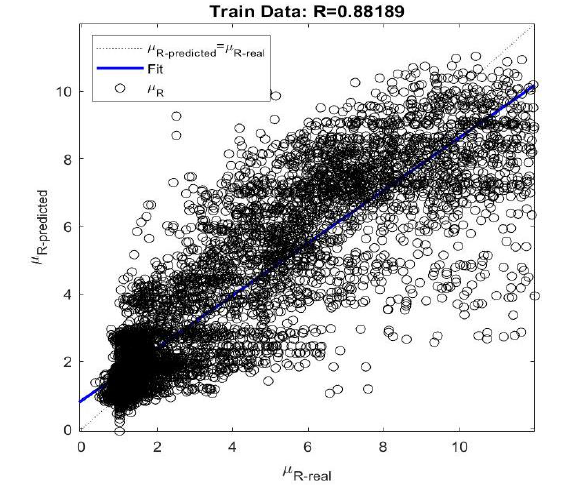
Figure 11. Correlation between the real and predicted values in training data (Subtractive clustering